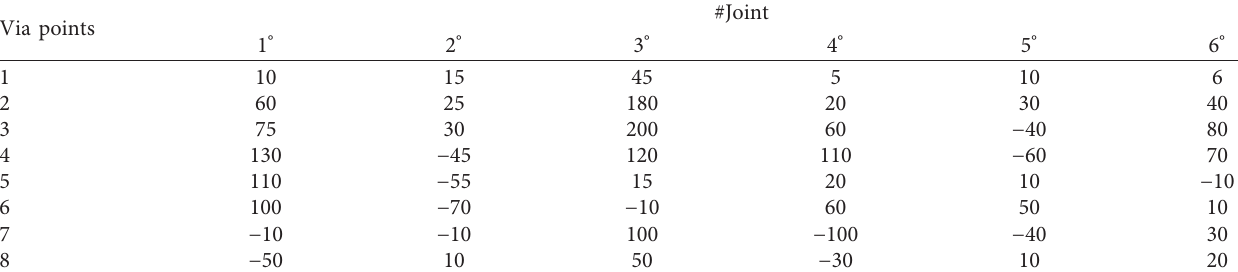
Table 3: Path defined by multiple